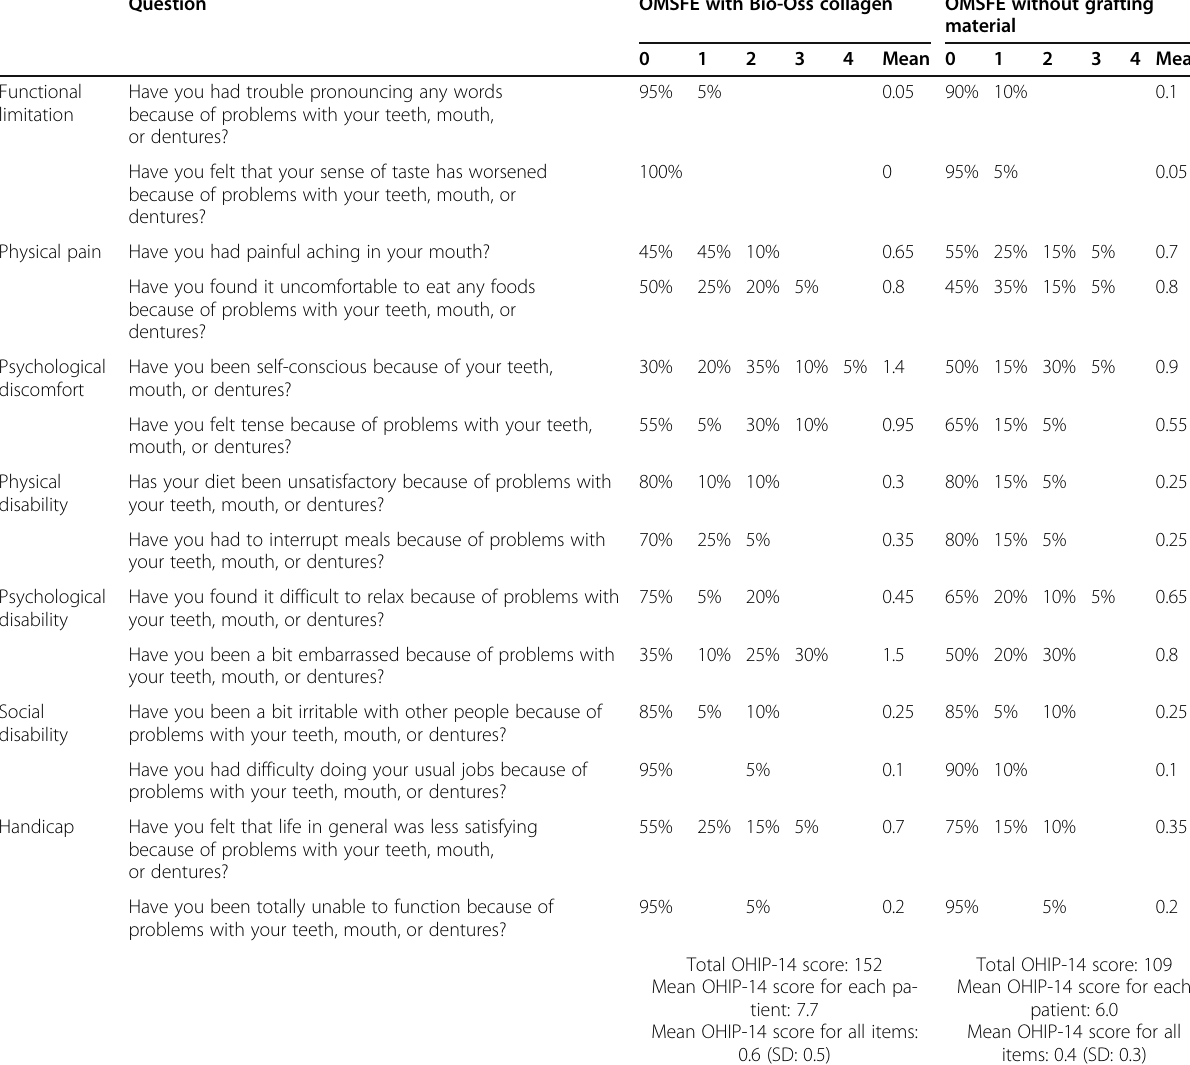
Table 3 Percentage distribution of responses to each question of OHIP-14 questionnaire